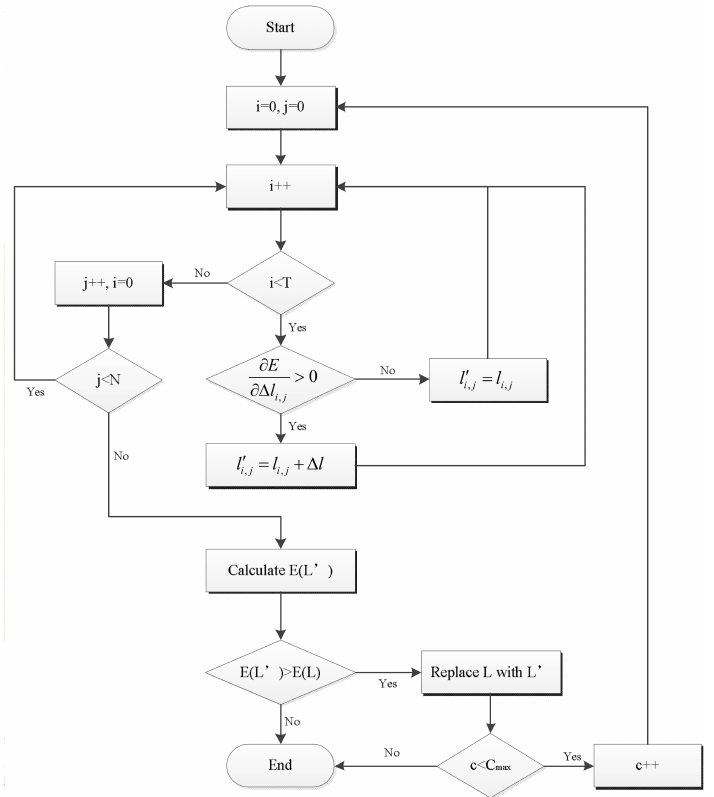
Figure 2. Flowchart of gradient-based search